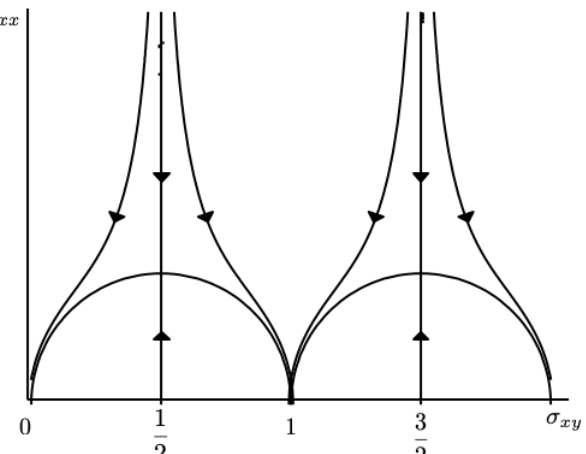
Figure 3: Schematic RG flow diagram for the integer QH effect in terms of the longitudinal and Hall conductivities. The effect of disorder increases with decreasing σ , ultimately driving the system into a state with quantized Hall conductivity. The xx = 1 critical line at σ separates states that flow to σ x y 2 from Refs. [ 66,67 ]